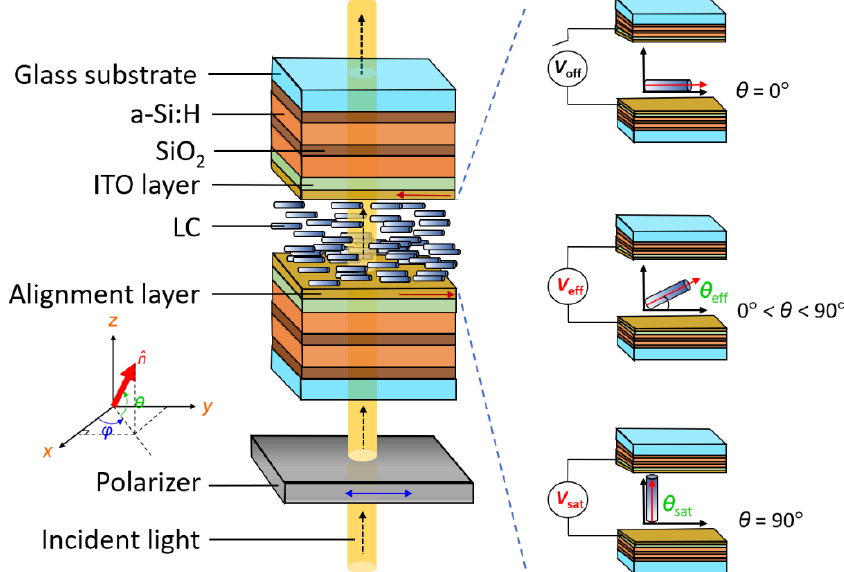
Figure 2. Schematic of the symmetrical configuration of the 1D PC/LC cell used to generate electri- cally tunable defect modes in the PBG specified by the dielectric multilayer. Note that the polarization angle (between the polarization direction of the linearly polarized beam and the unperturbed optic axis of the LC) is fixed at 0 ° .